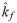
Illustration of modeling approach.a, Schematic illustration of binding kinetics (adapted from [59]). The grey squares depict the drug target molecules, and the blue circles represent antibiotic molecules within bacteria. The arrows indicate individual binding and unbinding events of the antibiotic to its target molecule in the cell. k^f is the adjusted forward reaction rate, kr is the reverse reaction rate, A is the concentration of antibiotics inside the bacterium, x is the number of bound targets, θ is the number of targets and Bx is the number of bacteria with x bound targets. b, Modeled sample time-kill curve, in which the sum of bacteria in all binding states (i.e., the entire population of living bacteria) is followed over time after exposure to antibiotics. The vertical dotted lines indicate the time points depicted in (c); 1 min (grey), 14 min (yellow), and 80 min (purple). c, The percentage of bound antibiotic targets in the bacterial population at indicated time points. d, Illustration of how the partial differential equation describes the bacterial population as a surface in a three-dimensional coordinate system, the dimensions of which represent percent bound target (x-axis), time (y-axis), and number of bacteria (z-axis). The three time points shown in (c) represent two-dimensional cross-sections at different points of the y-axis. e, Overview of used parameters and functions.